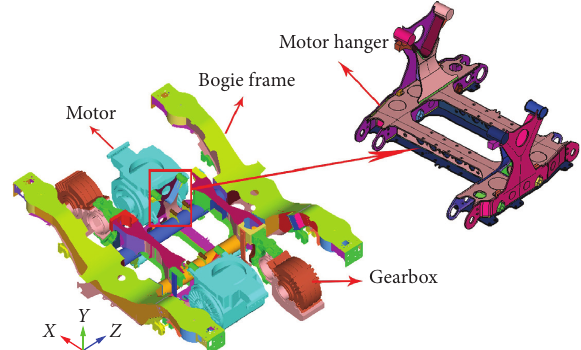
Figure 3: Geometric model of motor hanger.